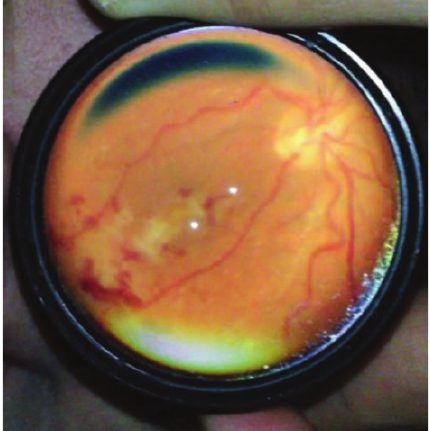
Figure 3: Retinoblastoma (partially treated) imaged during exami- nation under anesthesia.